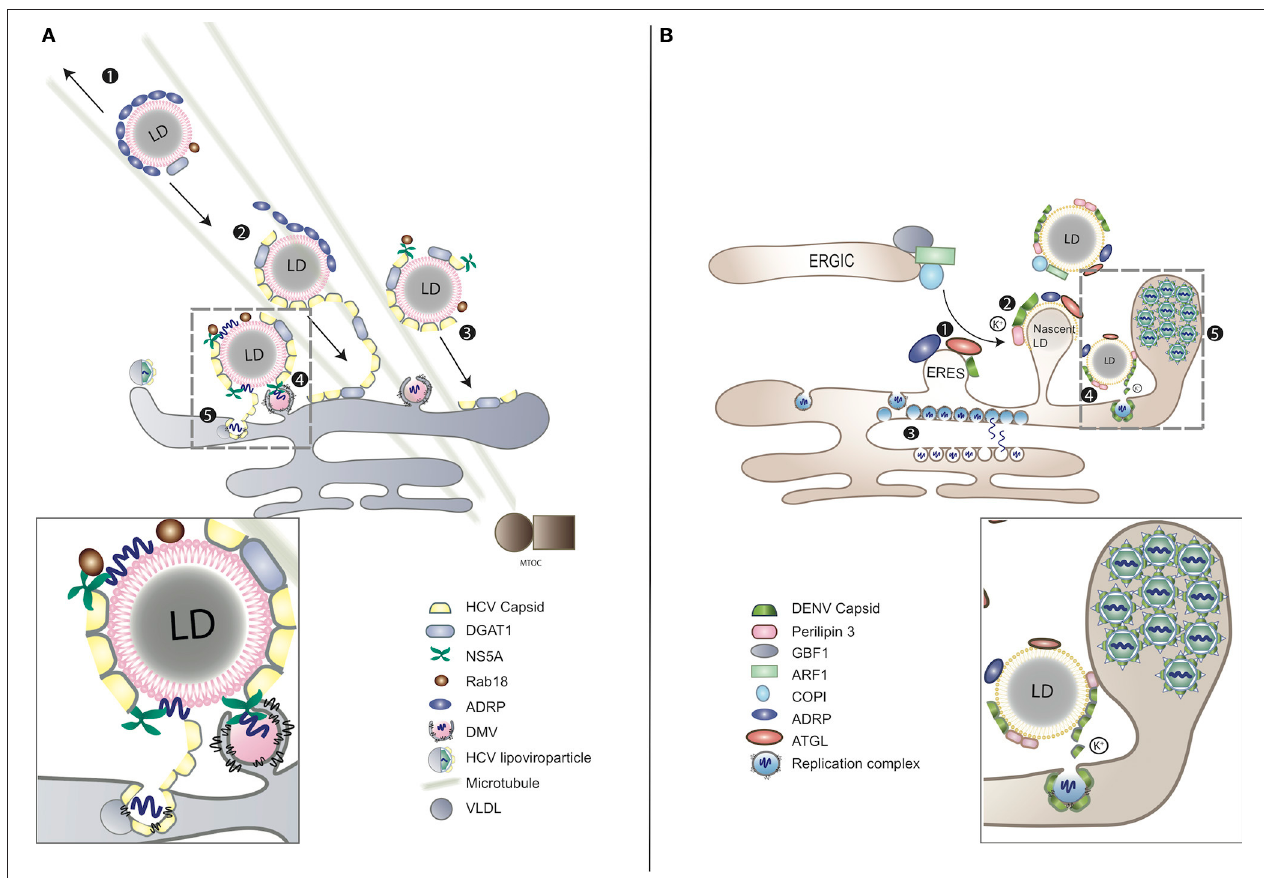
FIGURE 2 | LDs as platforms for virion assembly in (A) HCV and (B) DENV infection. (A) (1) ADRP-coated LDs are able to interact with microtubules and move toward both plus and minus ends. (2) During HCV infection, viral capsid protein replaces ADRP from LD surface with the assistance of DGAT1. (3) As the consequence of losing ADRP, LD losses the balance of mobility, moving toward MTOC and nucleus. (4) Clustering of LDs at the peripheral of nucleus enables the contact between LDs and the replication complex of HCV. HCV RNA is delivered from ER-bound replication complexes to NS5A, obtaining access to LD surface, followed by nucleocapsid formation (gray-dashed frame and enlarged panel). (5) The nucleocapsid fuses with VLDL to form viral lipoviroparticle in ER. (B) (1) At the ER–Golgi intermediate compartment (ERGIC), ARF1 and its guanine nucleotide exchange factor (GEF) GBF1 together with COPI deliver ATGL and ADRP from ER export sites (ERES) to the surface of LD. DENV subverts this process for the transportation of capsid protein to LD surface. (2) The accumulation of DENV capsid protein on LDs associates with cellular perilipin 3 and intracellular K + concentration. (3) Replicated DENV genomes are released through the vesicle pore and then engaged into nucleocapsids that bud through the ER membrane in close proximity. (4) Capsid protein can be released from LDs to the cytosol or other cellular compartments for subsequent viral assembly (gray-dashed frame and enlarged panel). (5) Packed virions accumulate within the lumen of the vesicle packets-containing ER network before transported to Golgi ( Boulant et al., 2008; Chatel-Chaix and Bartenschlager,